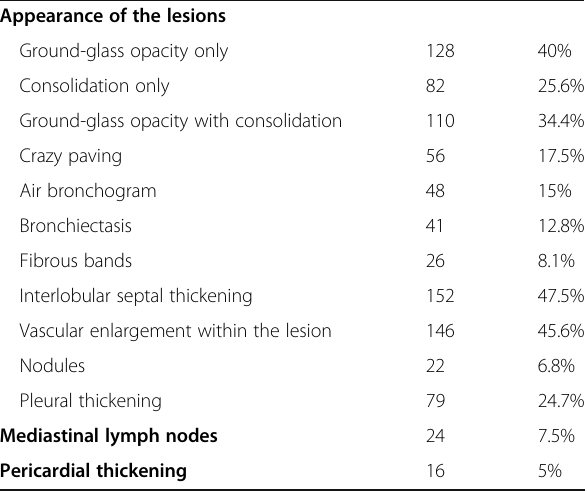
Table 2 Appearance of lesions and associated findings on chest